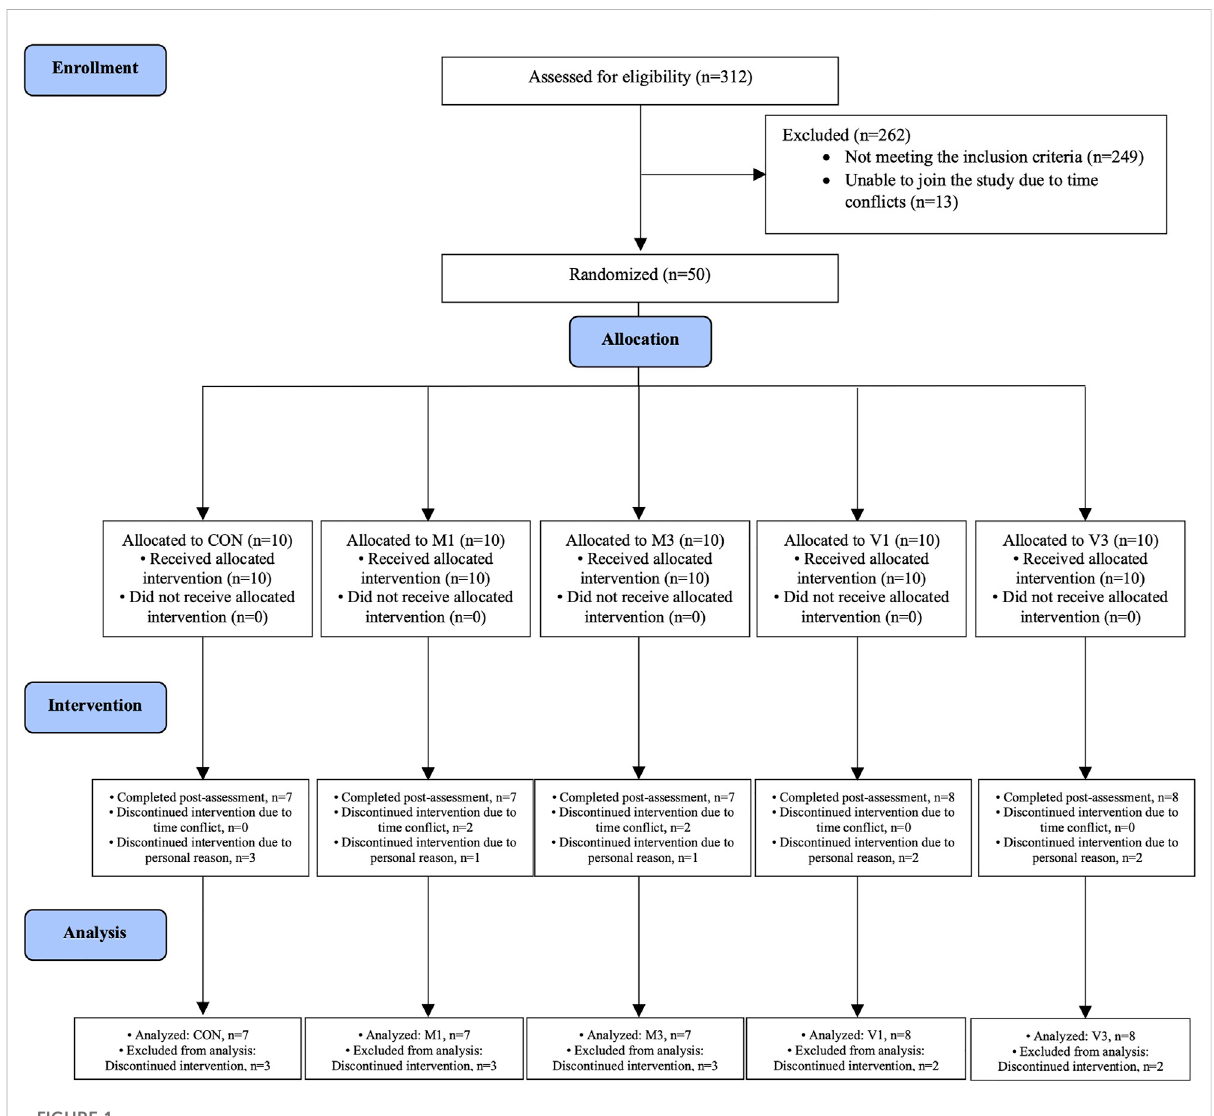
FIGURE 1 Schematic representation of participants screening, randomization and